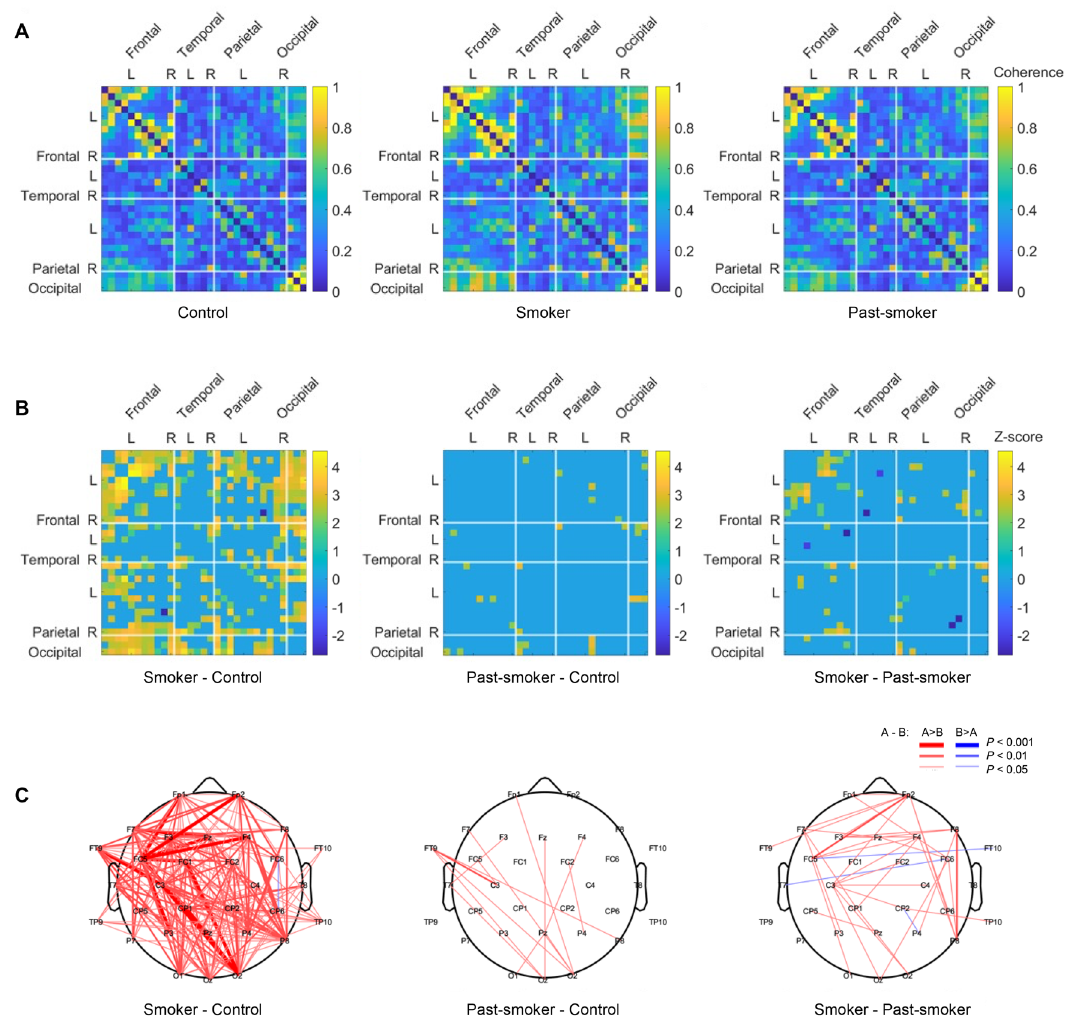
Figure 3. Group differences in alpha band coherence. ( A ) Alpha band coherence between EEG channels was calculated in each group. ( B ) Significant group differences in alpha band coherence were observed most distinctively between the Smoker and the Control groups. ( C ) For an illustrative purpose, all significant group differences in inter-channel coherences are depicted with three different thickness levels ( P FDR < 0.05, 0.01, and